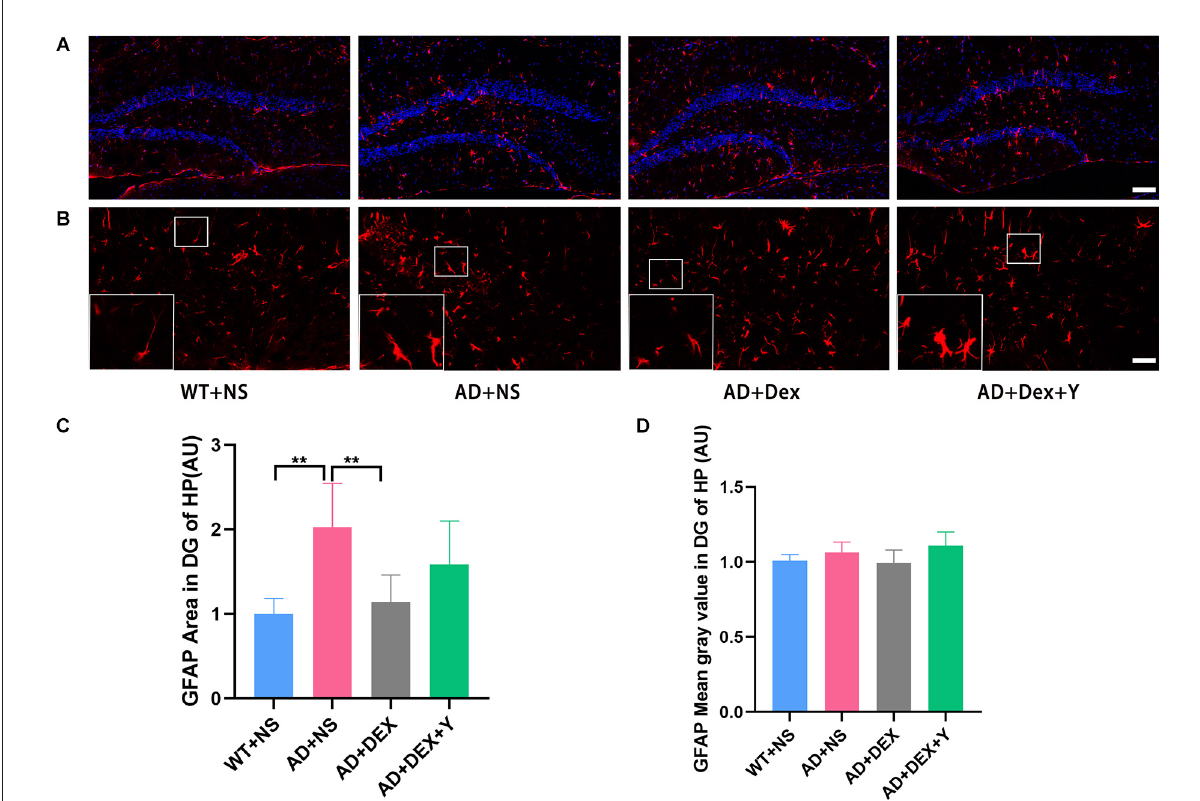
FIGURE4 Dexmedetomidine inhibited glial cell activation in the hippocampus DG of 5xFADmice (means ± SD, ANOVA, ** p < 0.01). (A) Representative images of GFAP-positive staining in the hippocampus DG from WT and 5xFAD mice, scale bars, 100 µ m. (B) High magnification images of GFAP-positive staining in the hippocampus DG from WT and 5xFAD mice, scale bars, 50 µ m. (C,D) The bar graph represents GFAP expression levels in the hippocampus DG.